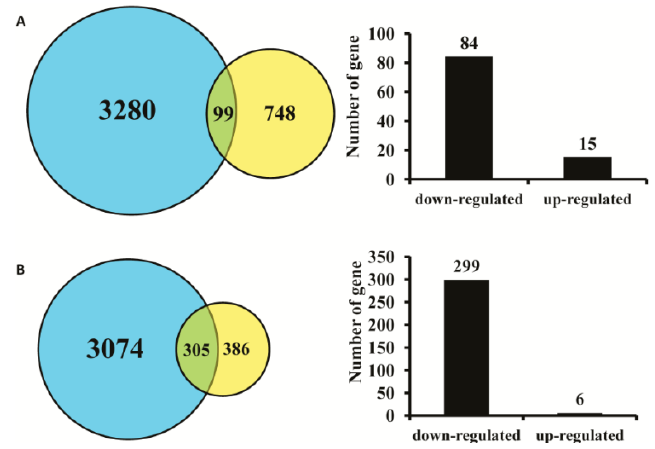
Figure 3. The impact of AC3 deletion on the expression of mature and immature olfactory neuron-specific genes. ( A ) Comparison of the microarray results with the immature olfactory neuron-specific expression genes [21], 99 genes overlap with the microarray results, among them 15 and 84 genes were up-regulated and down-regulated, respectively; ( B ) Compared results between the microarray data and the mature olfactory neuron-specific expression genes [21] indicating that 305 genes were overlapped, with 6 genes up-regulated and 299 genes down-regulated. In the Venn diagrams, the microarray results and the genes identified in [21] were marked in blue and yellow color, respectively.